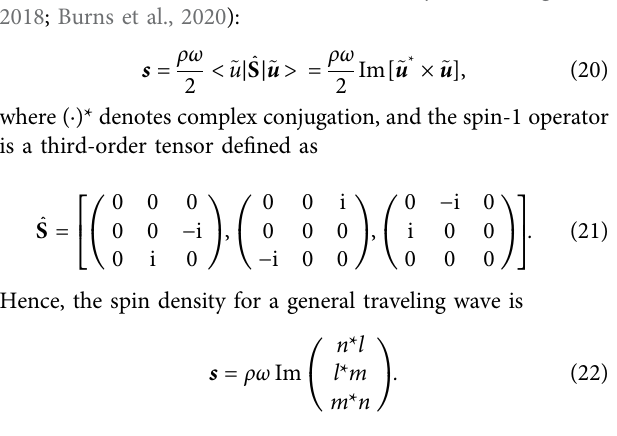
FIGURE 1 | The symmetry requirement for cubic materials: Body diagonals(orangesolidlines)ofacubicunitcellserveasthefouraxesofthree- fold rotational symmetry. They are the suf fi cient and necessary conditions for the cubic crystallographic point groups. On the contrary to some common misconceptions, cubic materials do not need to have any four-fold rotational